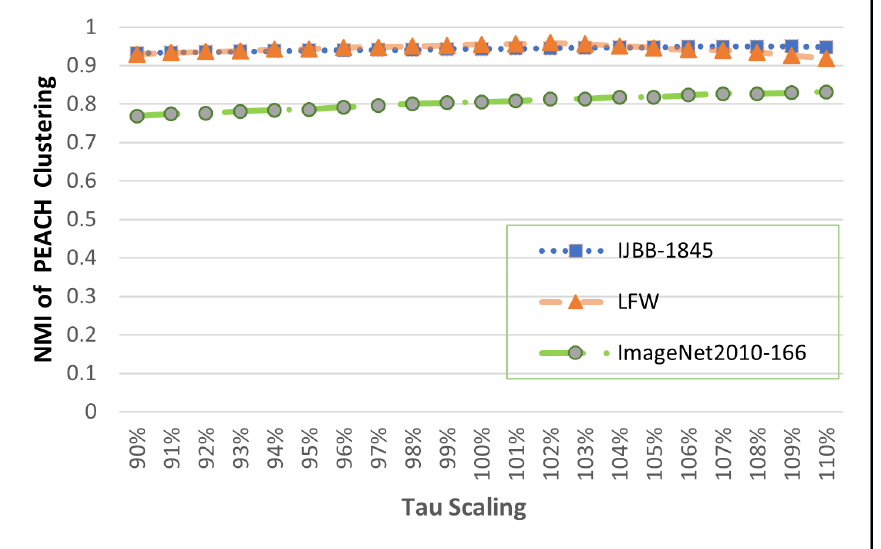
Figure 5. Different Scaling of τ r . The figure shows how stable the final NMI values are with respect to up to 10% perturbation of the threshold τ r used in PEACH( τ r ). Evaluating the IJB-B 1845, LFW, and ImageNet 360 protocols, we scale the automatically estimated τ r / τ w within the range of 90% to 110%. The figure shows that even a moderate change in threshold computation, e.g., by a few outliers, is not likely to break the PEACH